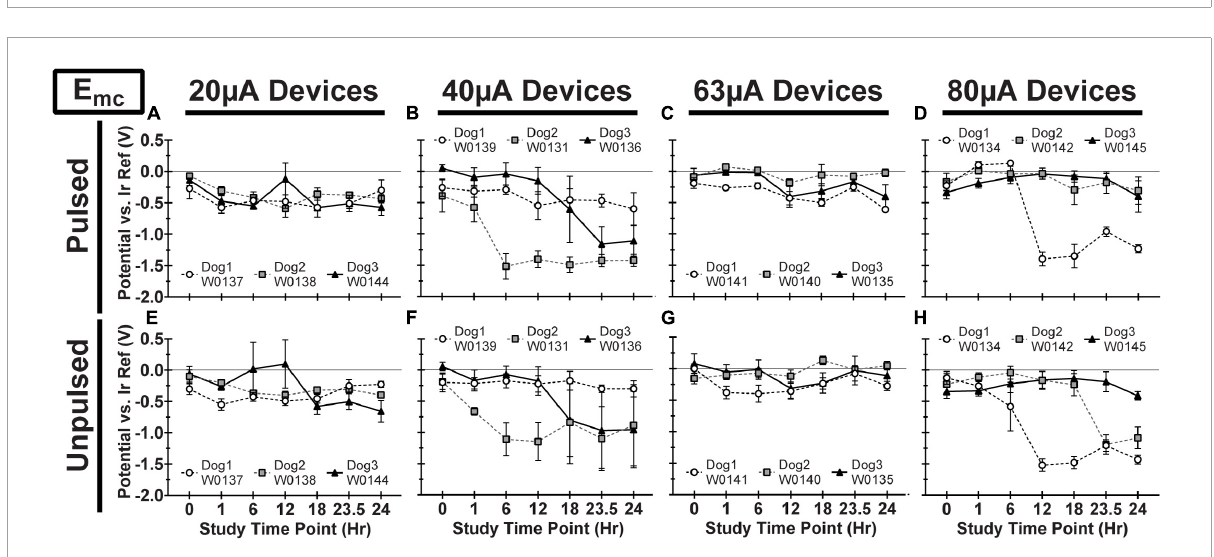
FIGURE7 Cathodic polarization potential (E mc ) vs. iridium reference electrode for pulsed (A–D) and unpulsed (E–H) electrodes in WFMA devices in the four different pulsing groups: 20 µ A (A) and (E) , 40 µ A (B) and (F) , 63 µ A (C) and (G) , and 80 µ A (D) and (H) . Voltage transients (VTs) were recorded at 0 h (before beginning the 24-h pulsing study), at 1h, 6h, 12h, 18h, and 23.5h (during the 24-h pulsing study), and at 24 h (after the 24-h pulsing study was complete). All VTs were recorded in response to 40 µ A, 200 µ s pulses. All data shown are mean and standard deviation across all electrodes within the group. All graph axes have the same